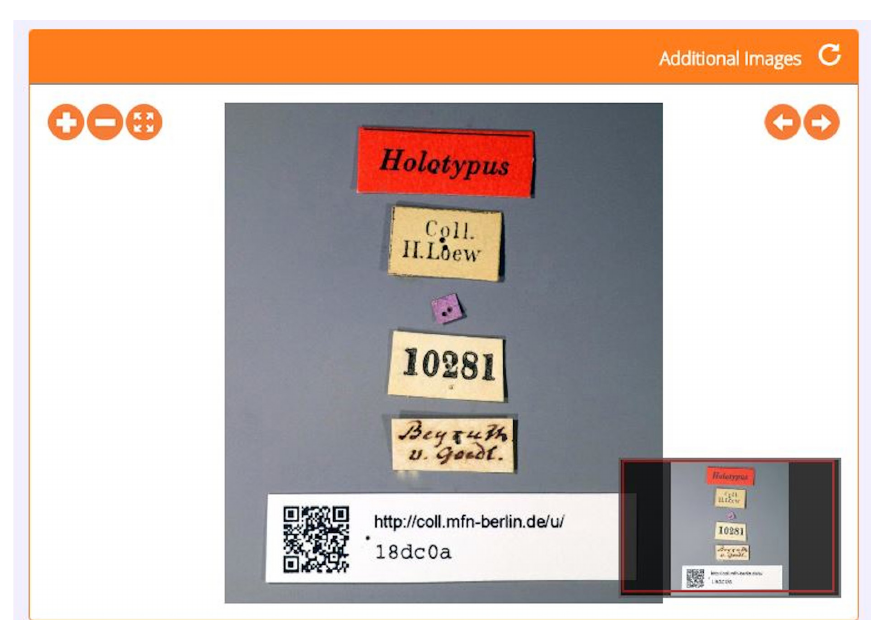
Fig. 2.25. Plane 4 of the specimen page at Zoosphere.net, showing the labels of the specimen. Image copyright MfN.